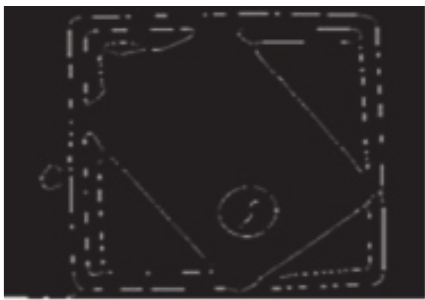
Figure 2: Model of casting mold on pallet.